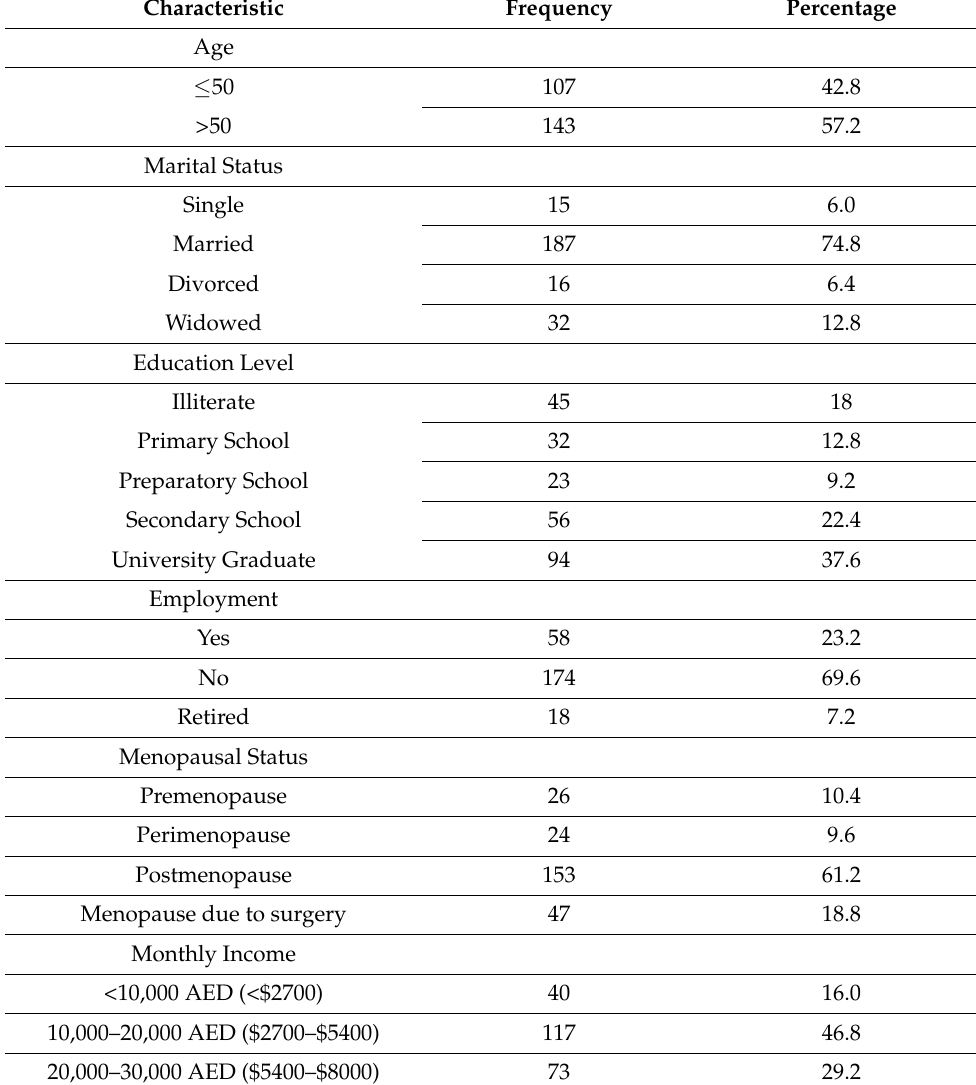
Table 1. Demographic data of the participants (N =